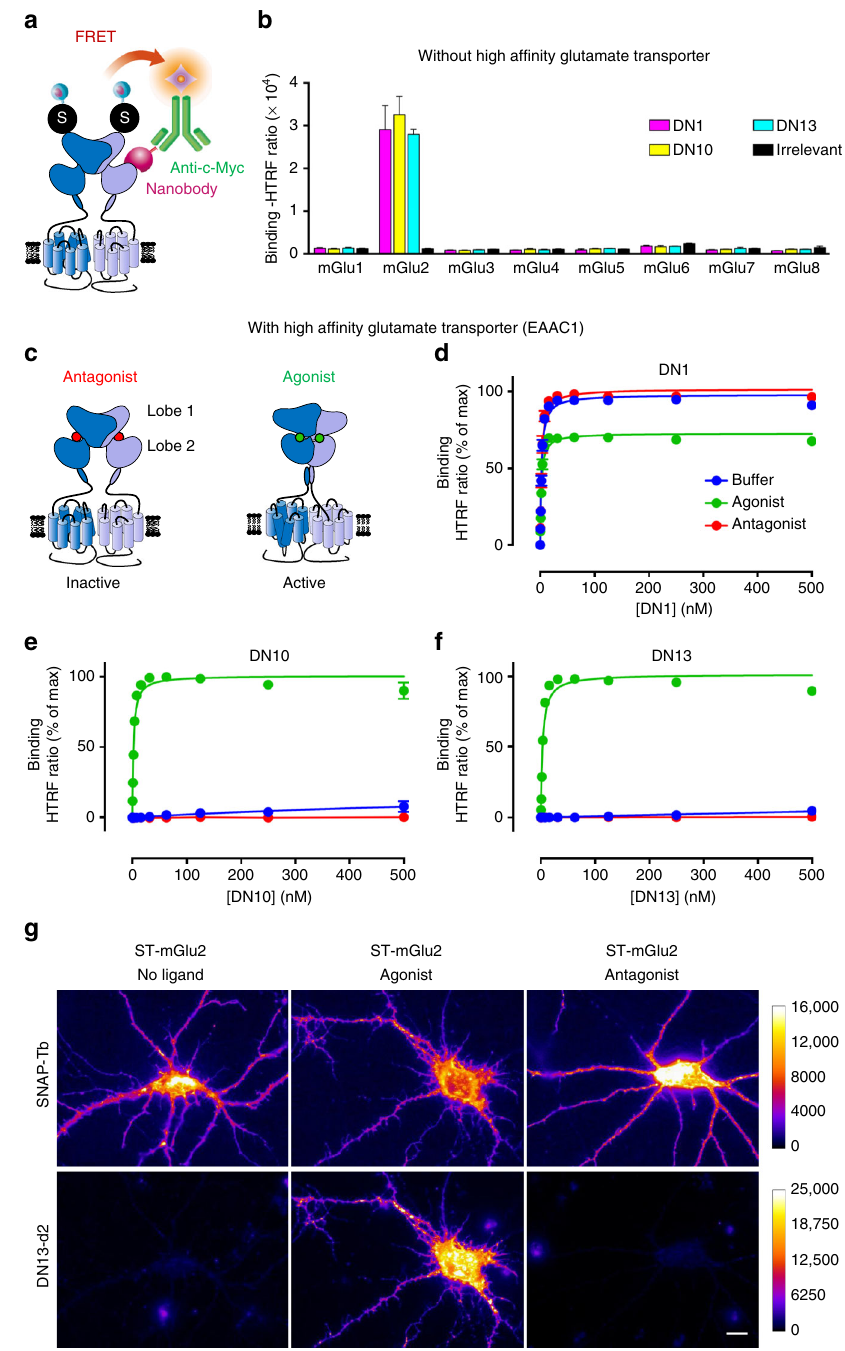
Fig. 1 Nanobodies DN1, DN10, and DN13 speci fi cally interact with mGlu2 receptors. a Cartoon illustrating the principle of the TR-FRET binding assay. The receptor fused to a SNAP-tag (black circled labeled “ S ” ) is labeled with Lumi4-Tb (light blue ball) while the nanobody (purple) bearing a c-Myc epitope at its C-terminus is labeled with 200 nM of anti-c-Myc antibody (green) coupled to d2 fl uorophores (orange). Binding of the nanobody to the receptor is then measured by a TR-FRET signal. b Speci fi c TR-FRET binding data obtained with the indicated mGlu receptor and either DN1, DN10, DN13, or a control irrelevant nanobody in cells under basal conditions with ambient glutamate (no high af fi nity glutamate transporter being co-transfected). Data are mean ± SD of triplicates from a typical experiment representative of three experiments. c Cartoon illustrating the main active (right), and inactive (left) conformation of an mGlu2 dimer, stabilized by an agonist (glutamate or LY379268) or the antagonist LY341495, respectively. d – f Saturation binding curves obtained with DN1 d , DN10 e , and DN13 f on mGlu2 receptors under control conditions in cells co-expressing SNAP-mGlu2 and the high af fi nity glutamate transporter EAAC1 (buffer), in the presence of the agonist LY379268 (1 µ M), or the antagonist LY341495 (10 µ M). Data are mean ± SEM of three individual experiments each performed in triplicates. g Fluorescence signals on cultured hippocampal neurons transfected with SNAP-mGlu2 and labeled either with SNAP-Lumi4-Tb (top) or DN13-d2 (100 nM) (bottom), under basal, agonist (LY379268, 1 µ M) or antagonist (LY341495, 10 µ M) conditions. Scale bar: 20 µ